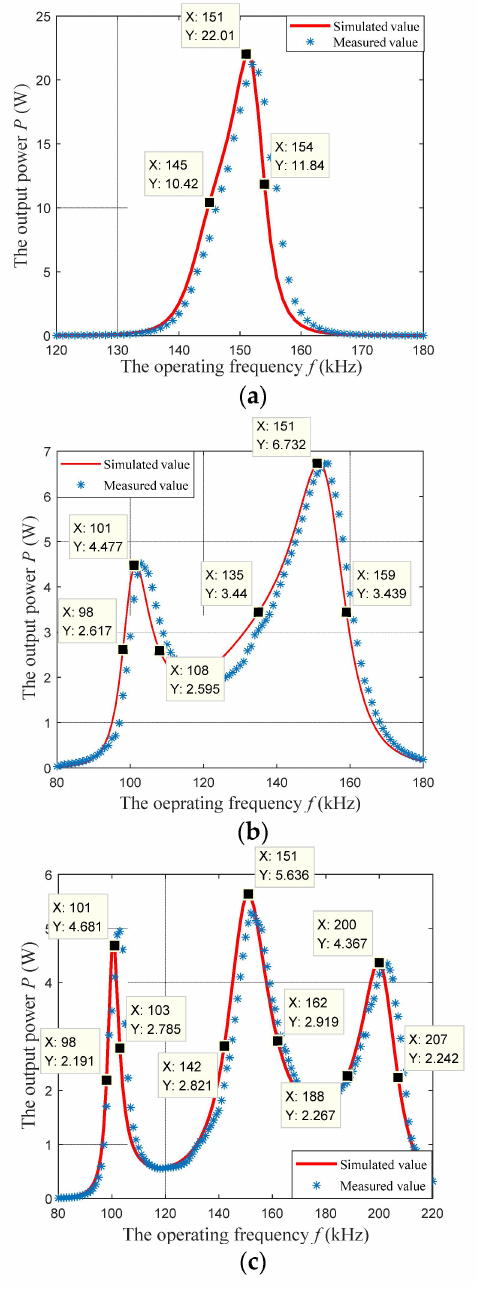
Figure 5. The simulated and measured power versus the operating frequency of the tri-coil systems. ( a ) single-band system ( k = 1). ( b ) dual-band system ( k = 2). ( c ) Three-band system ( k = 3).